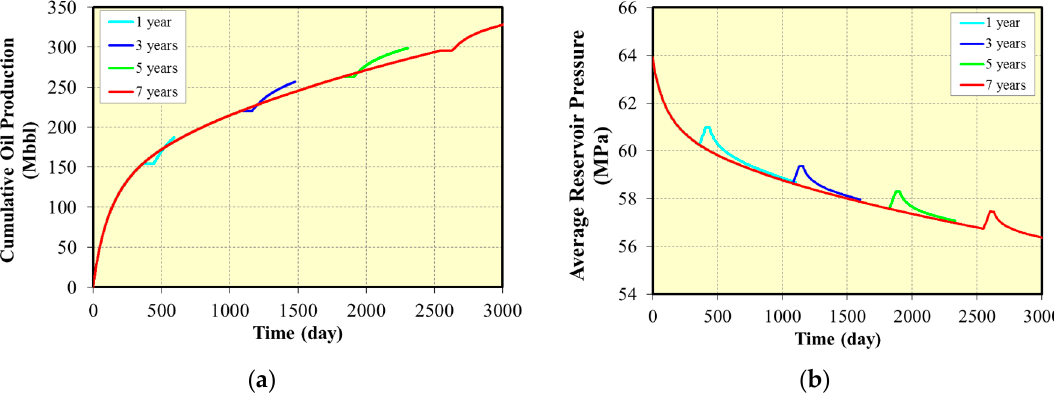
Figure 26. Effect of different periods of primary depletion with one huff-n-puff cycle on oil production and reservoir pressure: ( a ) Cumulative oil production for different period of primary depletion; ( b ) Average reservoir pressure for different period of primary depletion.